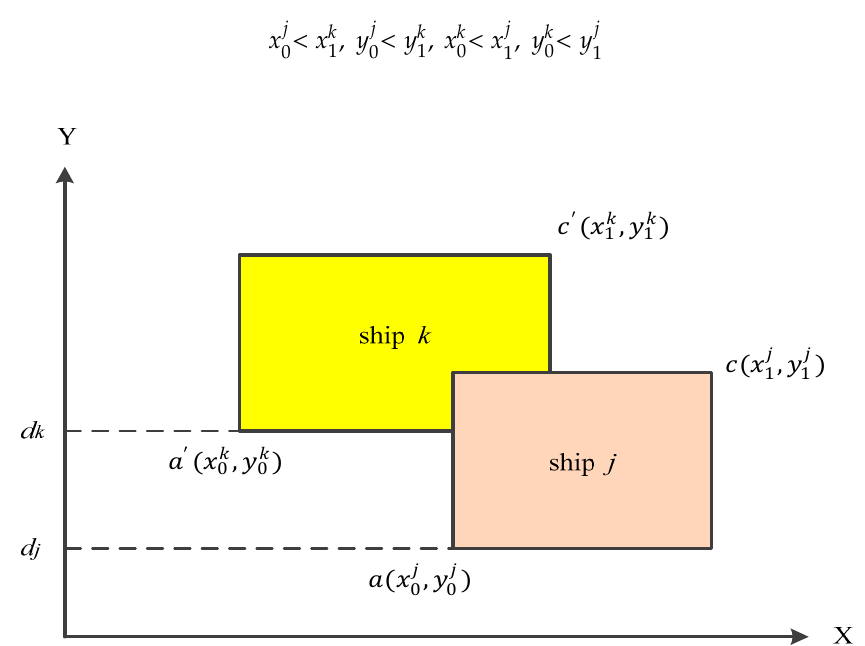
Figure 7. The coordinates of the corner points of ships j and